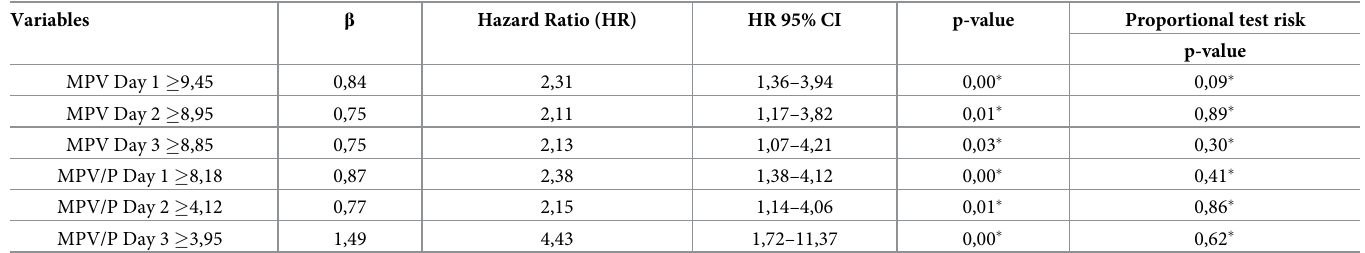
Table 4. Cox regression for the survival of patients with